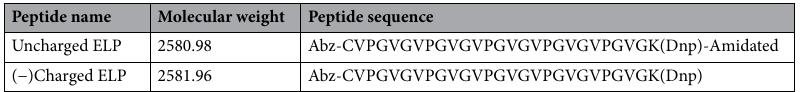
Table 1. The ELP sequences designed for this study consist of uncharged ELP and (−)charged ELP at neutral pH. Both peptides have five repeats of the VPGVG pentapeptide sequence, 2-aminobenzoyl (Abz) followed by cysteine amino acid at the N-terminus, and 2, 4-dinitrophenyl (Dnp) attached to the amine functional group on lysine (K) before the